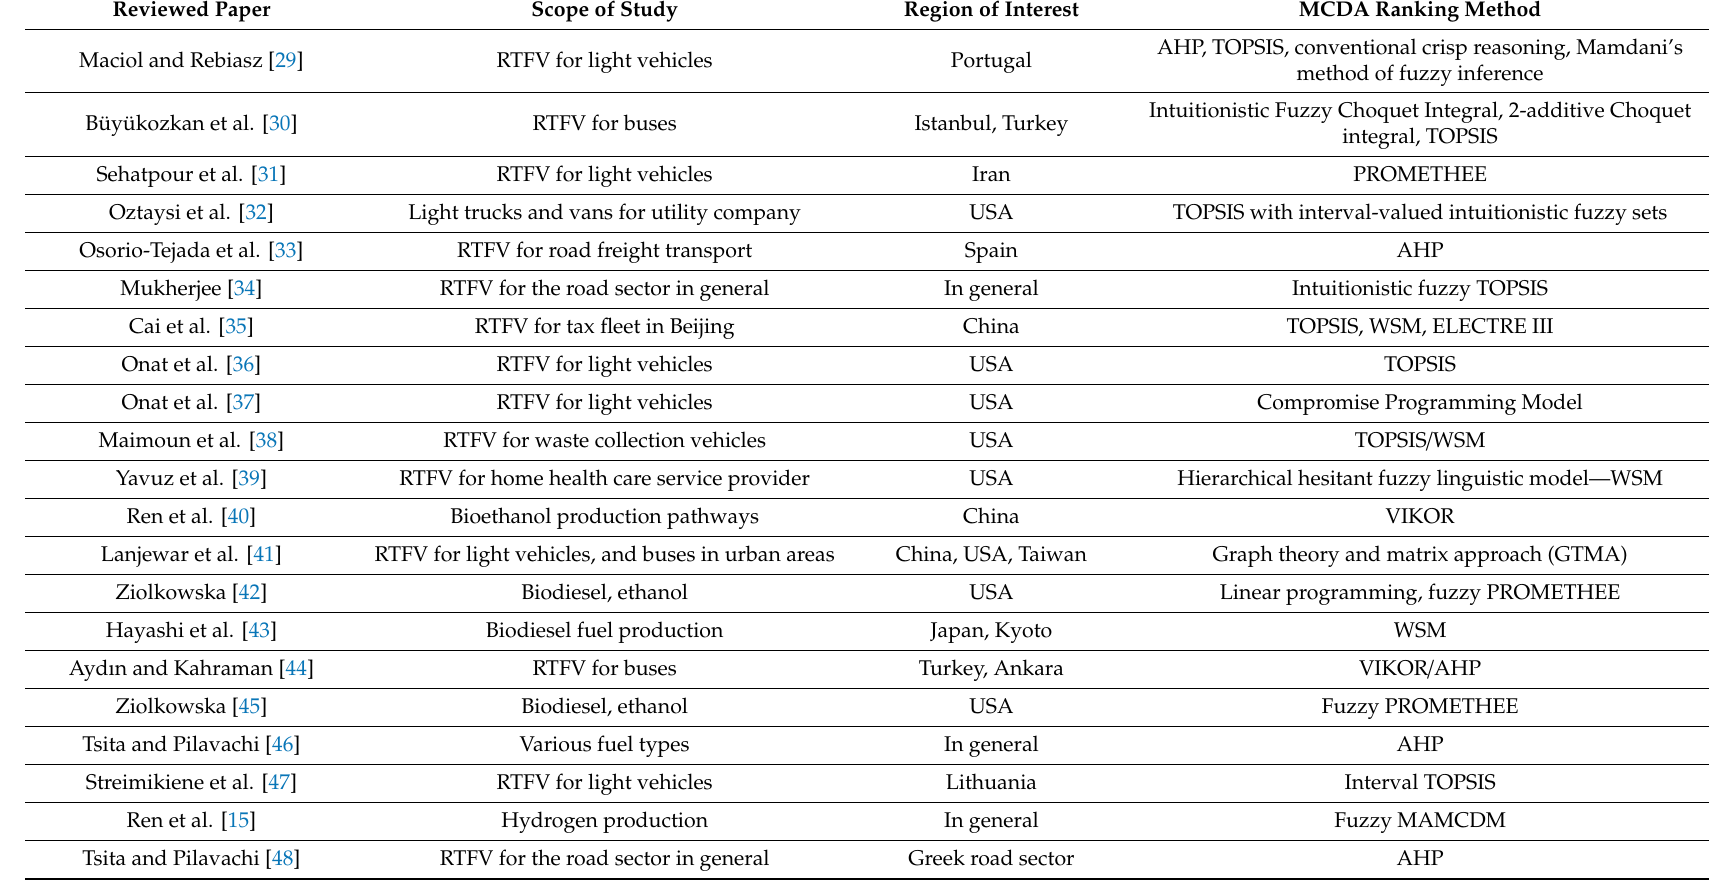
Table 4. Summary of reviewed papers and their evaluation